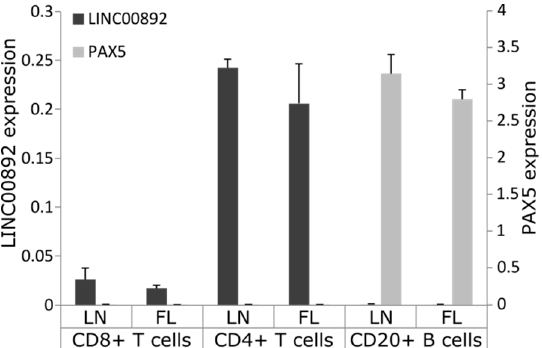
Figure 3. Expression analysis of LINC00892 and PAX5 in sorted cells. The analysis of gene expression of LINC00892 and PAX5 (as a B-cell marker) was performed using RT-qPCR from RNA extracted from CD4+ T cells, CD8+ T cells and CD20+ B cells sorted from a lymph node (LN) hyperplasia sample and an FL sample. The experiment has been performed in triplicate. GUSB was used as reference gene.